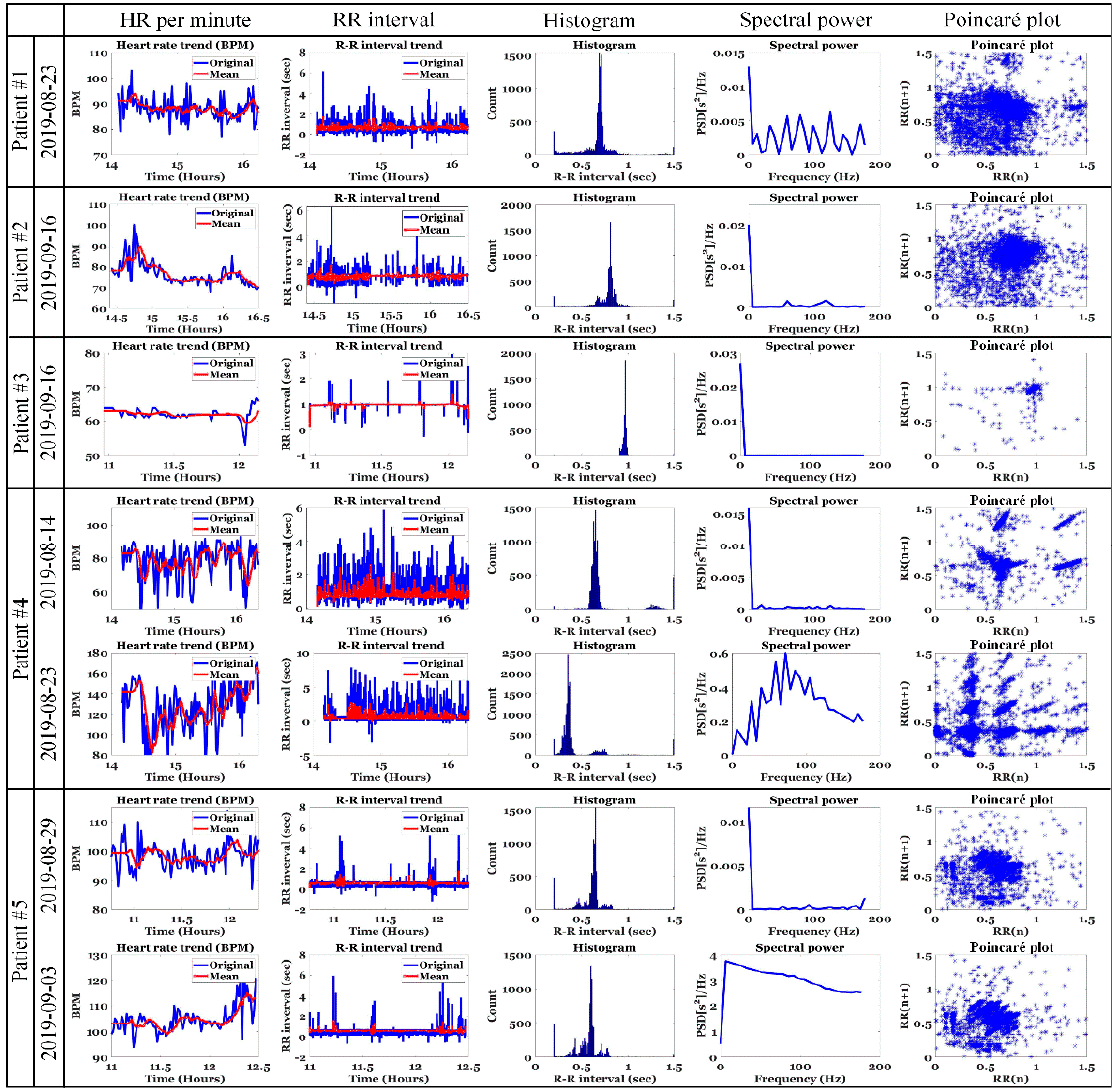
Figure 11. HRV results at the time of hypotension in hemodialysis patients.